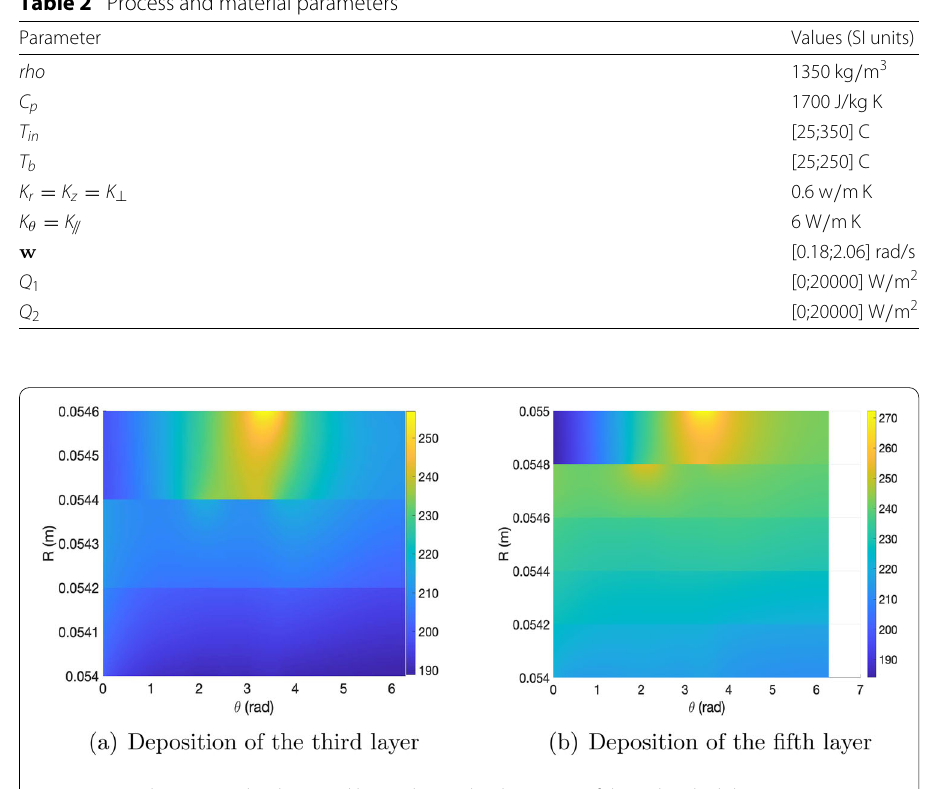
and 7. The experimental results show large variability. Only 4 experiments were available to compute the mean and the standard deviation. The results are shown for w = 0 . 0533 rad/s, Q 1 = 9250 W / m 2 and Q 2 = 4500 W / m 2 . T in and T b are experimental